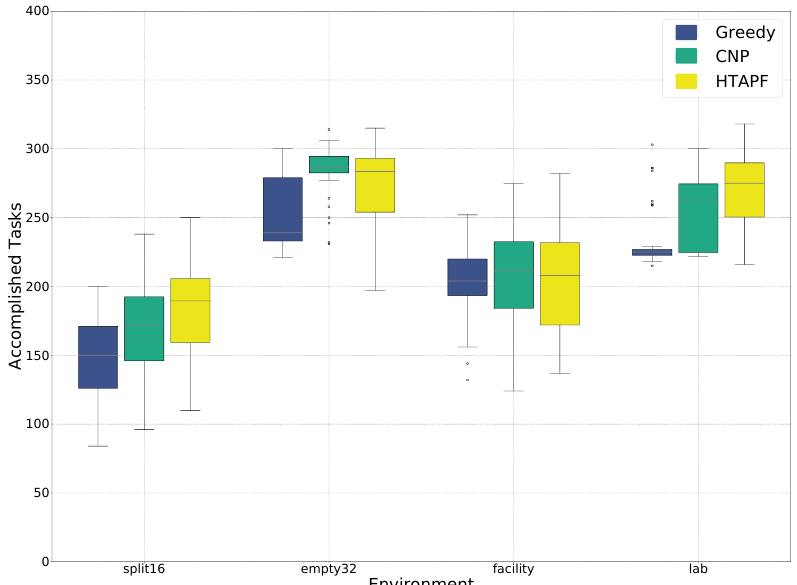
Figure 5. Number of accomplished tasks by the different approaches (greedy, Contract Net Protocol (CNP), and HTAPF) across the different environments, obtained with unlimited communication and no robot failures. For each condition, 50 independent simulations are performed and the data displayed by a box-and-whiskers plot. Each box represents the inter-quartile range of the data, and the median is displayed as a line cutting the box in two parts. Whiskers extend to 1.5 times the top and bottom quartiles. Dots represent